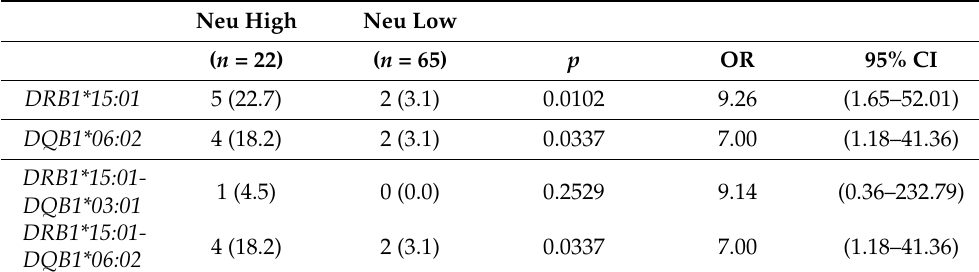
Table 3. HLA allele or haplotype carrier frequencies in RA patients with higher or lower titers of anti-SARS-CoV-2 neutralizing